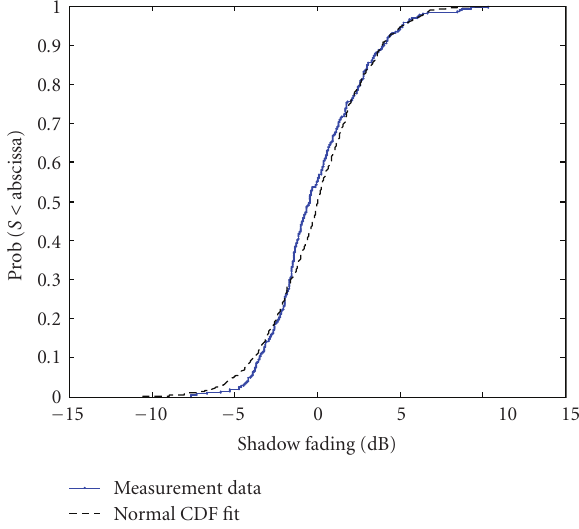
Figure 7: CDF of shadowing fading fit for normal distribution- NLOS